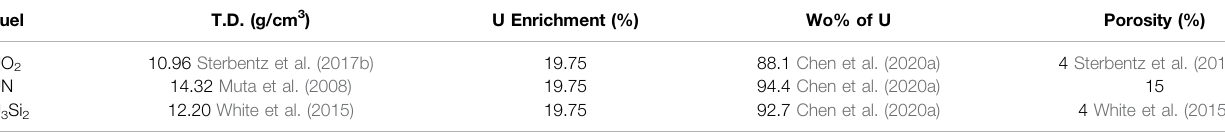
TABLE 3 | Key parameters of the three fuel materials.